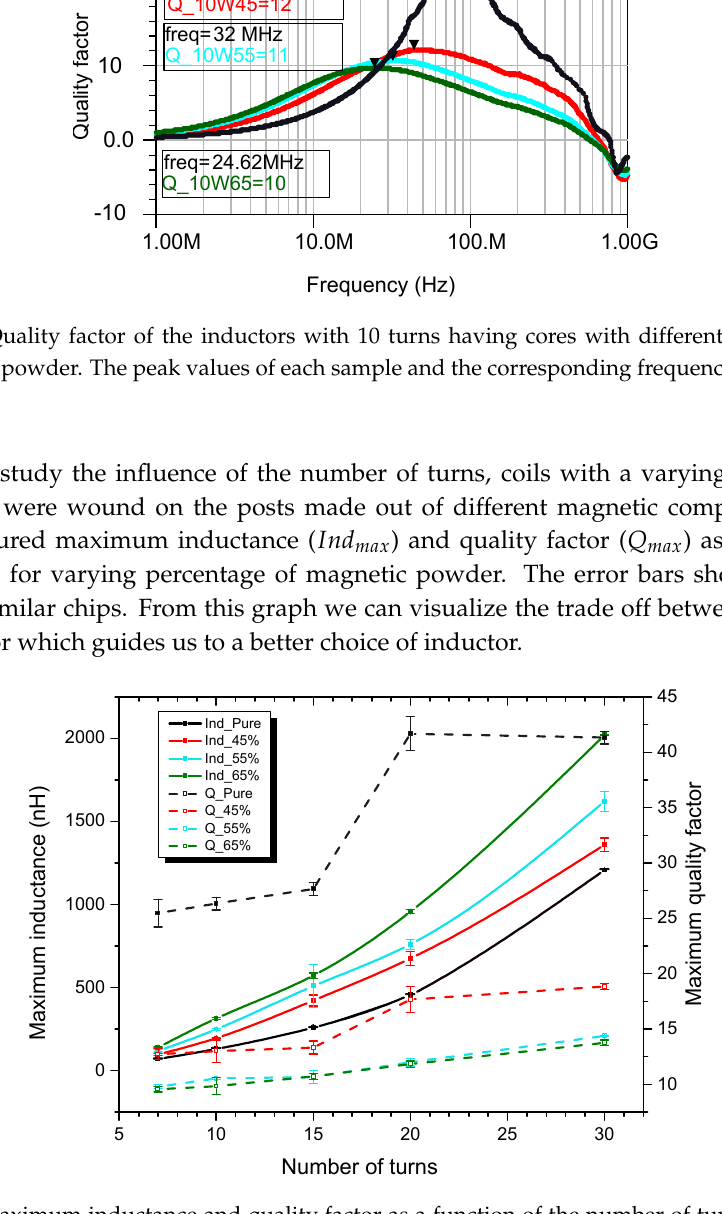
Figure 13. Maximum inductance and quality factor as a function of the number of turns for varying percentage of magnetic powder. The dotted lines indicate the Q max and the solid line the Ind max